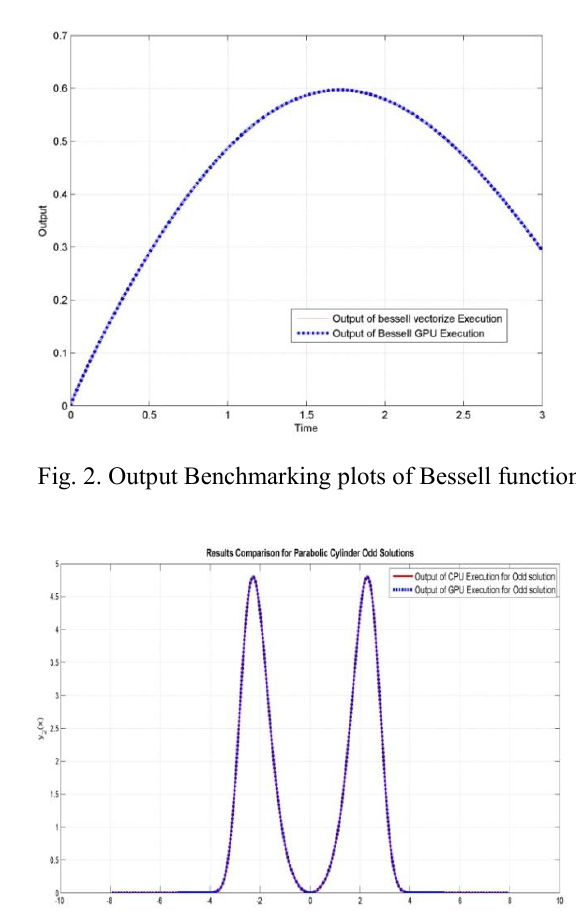
Fig. 1. Output Benchmarking plots of Wright function .